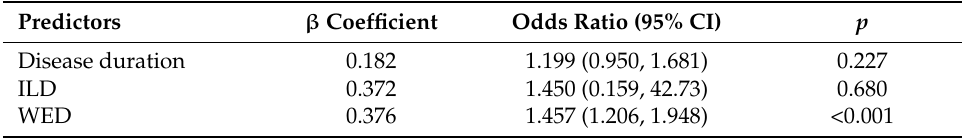
Figure 3. Selection of demographic and clinical features using the LASSO binary logistic regression model. Optimal parameter ( λ ) selection in the LASSO model using minimum criteria. The partial likelihood deviance (binomial deviance) curve was plotted versus log ( λ ). Dotted vertical lines were drawn at the optimal values by using the minimum criteria and 1 SE of the minimum criteria (the 1-SE criteria). LASSO: least absolute shrinkage and selection operator; SE: standard error. Table 2. Multivariate regression model for esophageal dysmotility in SSc.